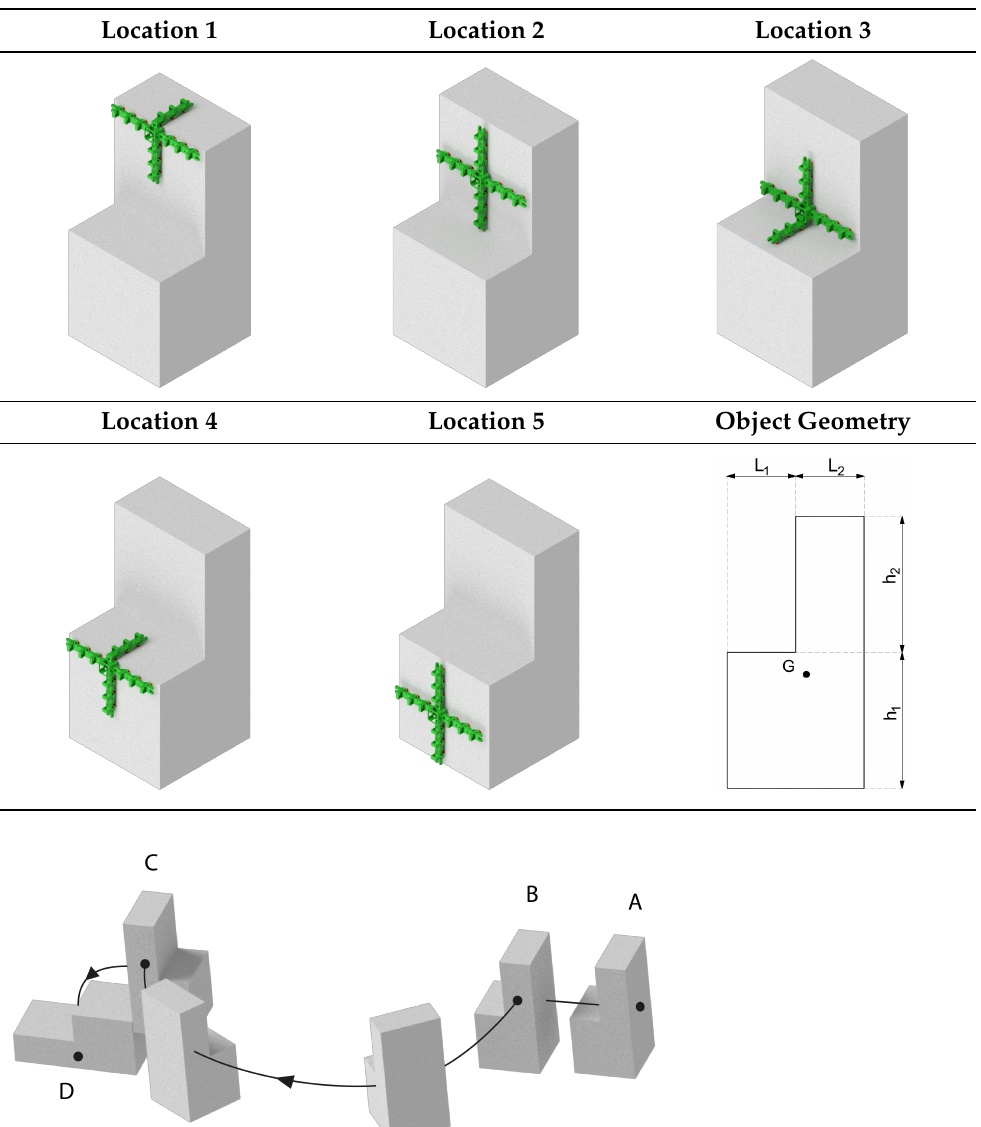
Table 1. This table reports the grasping locations used with the irregular rectangular prism. On the right side of the bottom row, there is a schematic representation that shows the center of mass G and the object dimensions ( L 1 = L 2 = 34 cm, h 1 = h 2 = 68 cm, the width of the object is 68 cm).